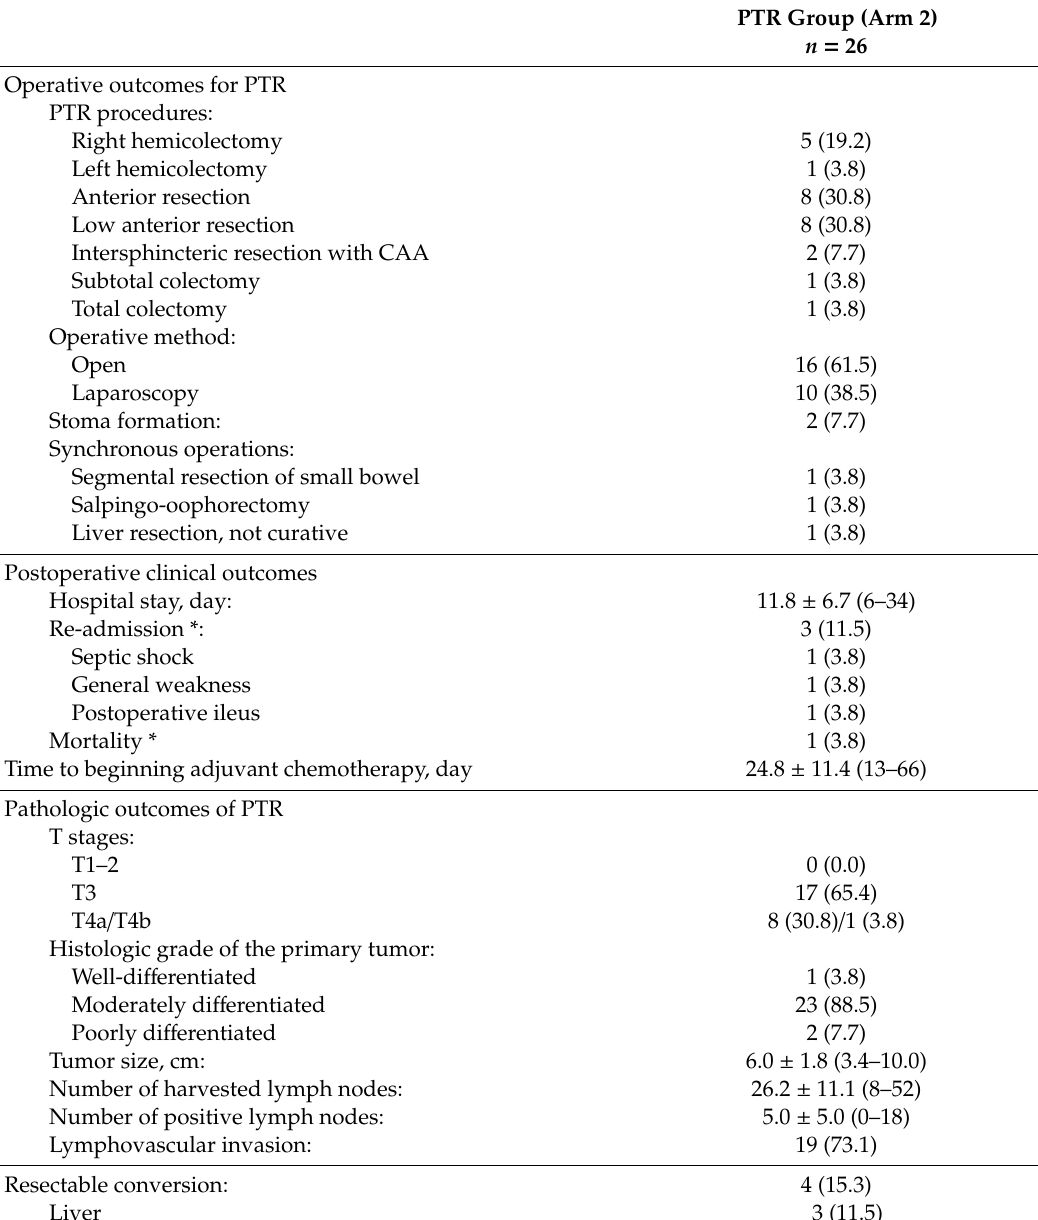
Table 3. Clinical and pathologic manifestations in the PTR